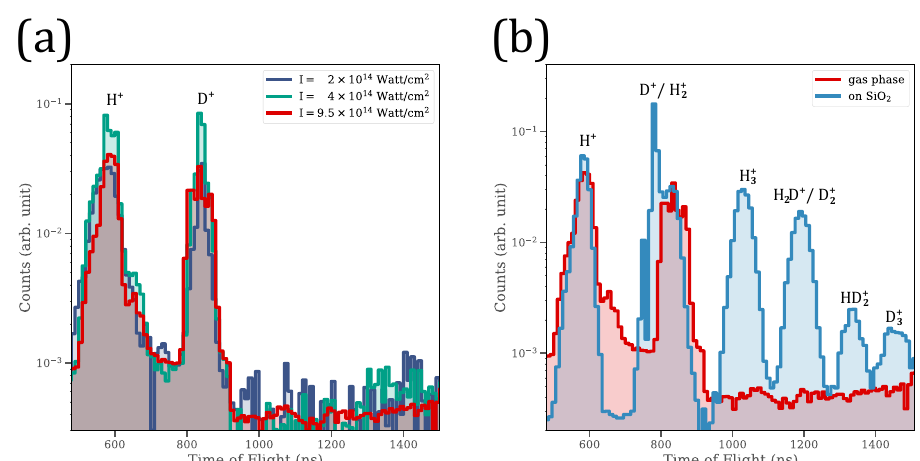
Fig. 2 Ion emission from D 2 O in gas phase and on nanoparticles. a Comparison between time-of- fl ight spectra for D 2 O in the gas phase for different laser intensities as indicated. The observed H + ions originate from background gas. b Comparison between TOF spectra taken for D 2 O in the gas phase at 9.5 × 10 14 W/cm 2 laser intensity and ions emitted from the surface of 100 nm nanoparticles inhabited by D 2 O molecules at a laser intensity of 1 × 10 14 W/cm 2 . Only the spectrum associated with nanoparticles demonstrates the formation of D þ